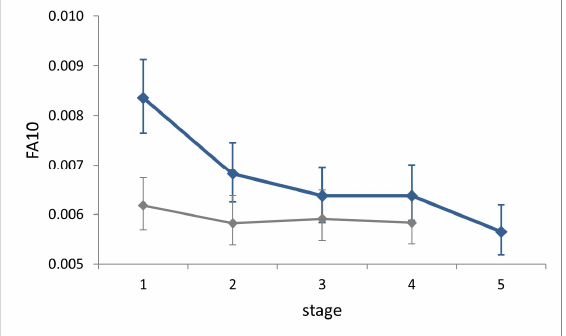
Figure 6. Ontogenetic progression of fluctuating asymmetry (measured as FA10 ) during the five larval stages in P. brassicae . Continuous blue line, field dataset; grey line, laboratory dataset (from [8]). Bars are 95% confidence intervals.